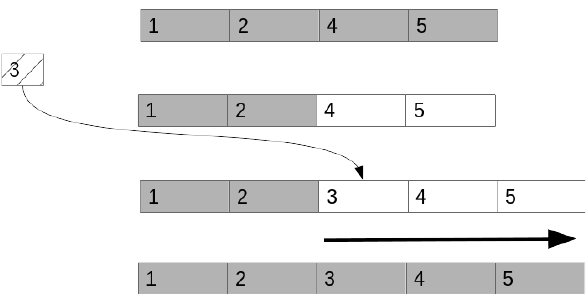
Figure 6. Adding a New Object to a Lock